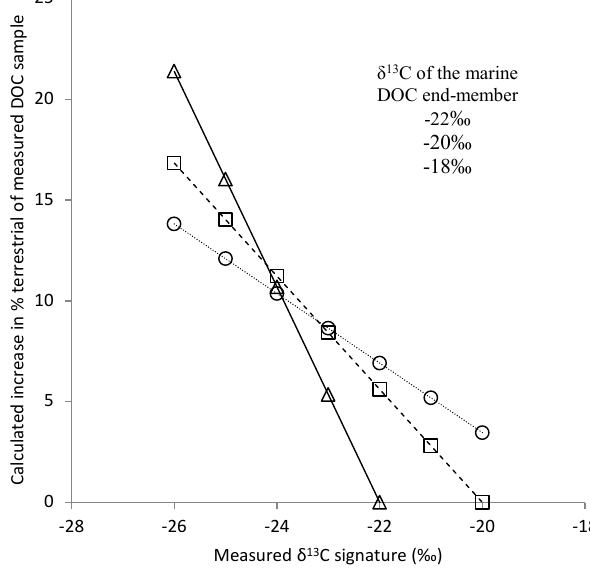
Figure 6. Percent increase in the contribution of terrestrial DOC (100 × fraction terrestrial from Eq. 1) when the δ 13 C of photooxi- dized riverine water ( − 26.6‰) is used instead of the δ 13 C of unal- tered riverine water ( − 28.1‰) in a simple two-end-member mixing model over a range of measured δ 13 C signatures. Three theoretical δ 13 C values for the marine DOC end-member ( δ 13 C= − 18, − 20 or − 22‰) were used to cover the vast majority of possible signatures for phytoplankton-derived DOC in the world ocean (Bauer, 2002; Yu et al.,